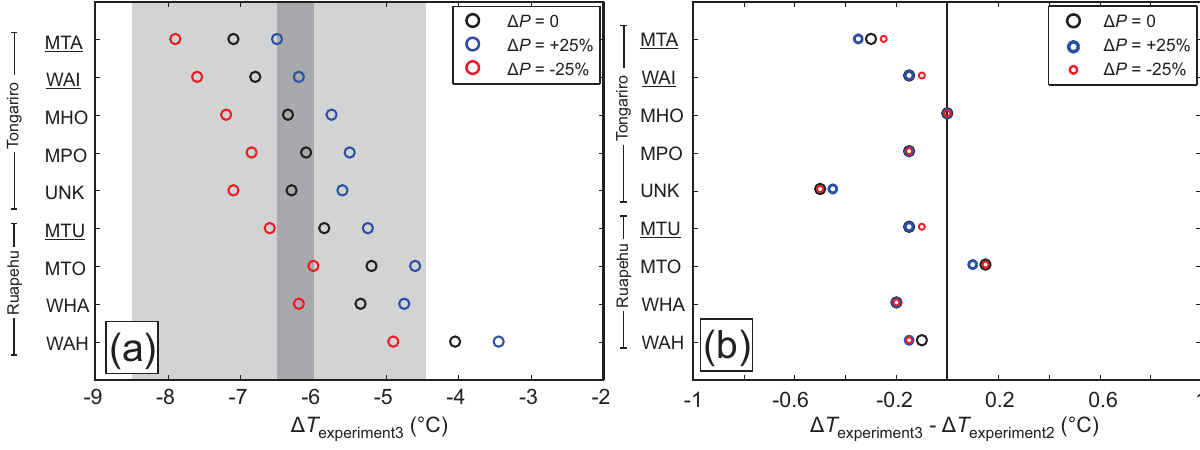
Figure 8. Experiment 3. (a) Temperature forcing, from present ( (cid:49)T experiment3 ), necessary to simulate inferred LGM ice geometries in catchments on Mt Ruapehu and Tongariro massif, using the modified, pre-15ka topography. Results shown for three precipitation change ( (cid:49)P ) scenarios: 0% (black), + 25% (blue), and − 25% (red) change from present. Underlined labels on the y axis represent catchments where modelled ice thickness spills over ice-marginal landforms, before reaching the geologically inferred terminus (see text). Vertical black lines and light-grey shading depict the pollen-based southern North Island LGM temperature estimate of Newnham et al. (2013) (6.5 ± 2.0 ◦ C) – derived using the partial least-squares method. Dashed black lines and dark-grey shading depict the glacier-model-derived Southern Alps LGM temperature estimate of Golledge et al. (2012) (6.0–6.5 ◦ C, when precipitation is reduced by 25%). (b) The difference in (cid:49)T between model simulations in Experiment 3 ( (cid:49)T experiment3 ) and Experiment 2 ( (cid:49)T experiment2